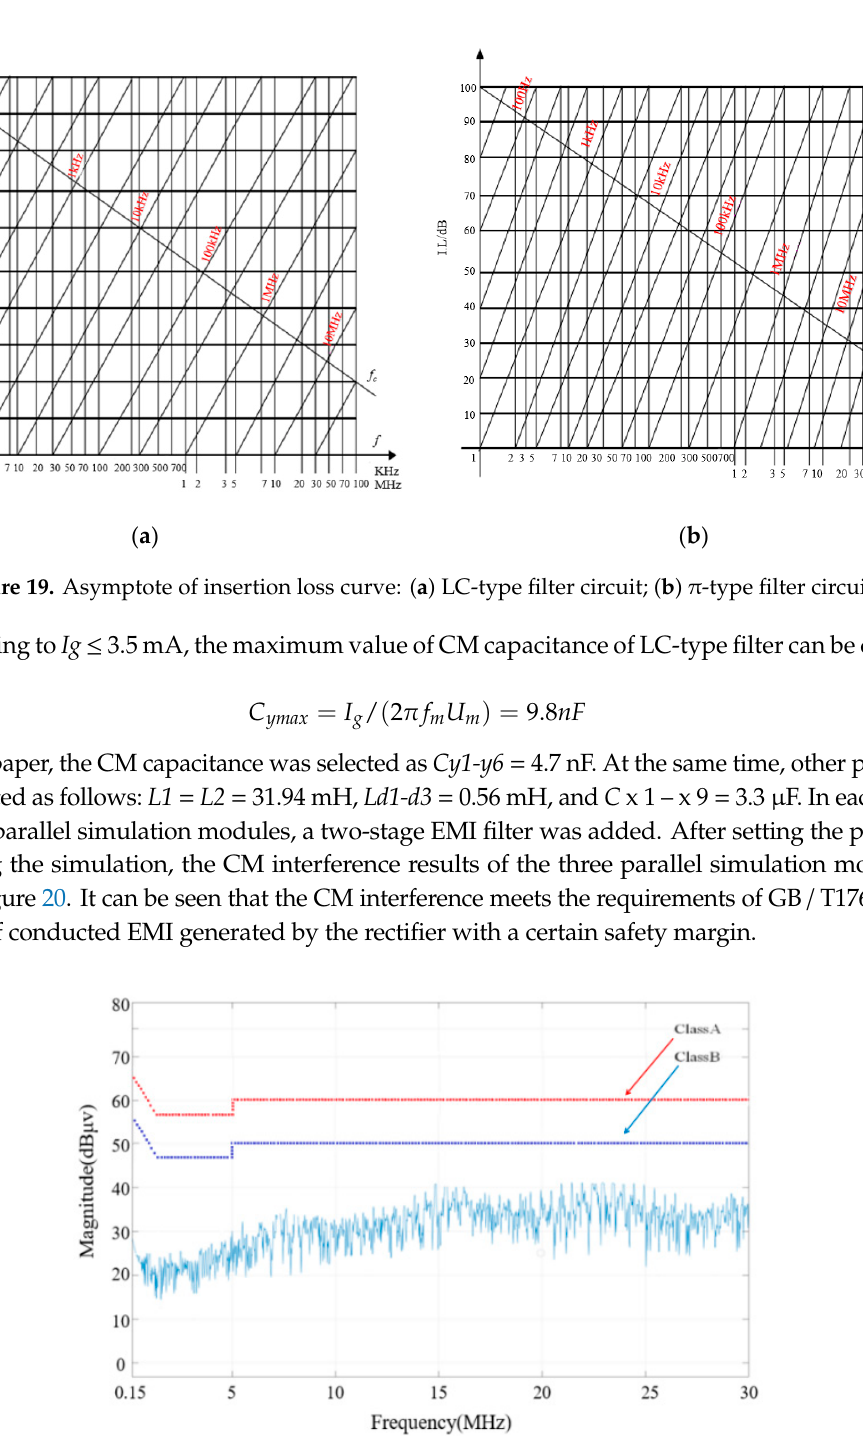
Figure 19. Asymptote of insertion loss curve: ( a ) LC-type filter circuit; ( b ) π -type filter circuit.